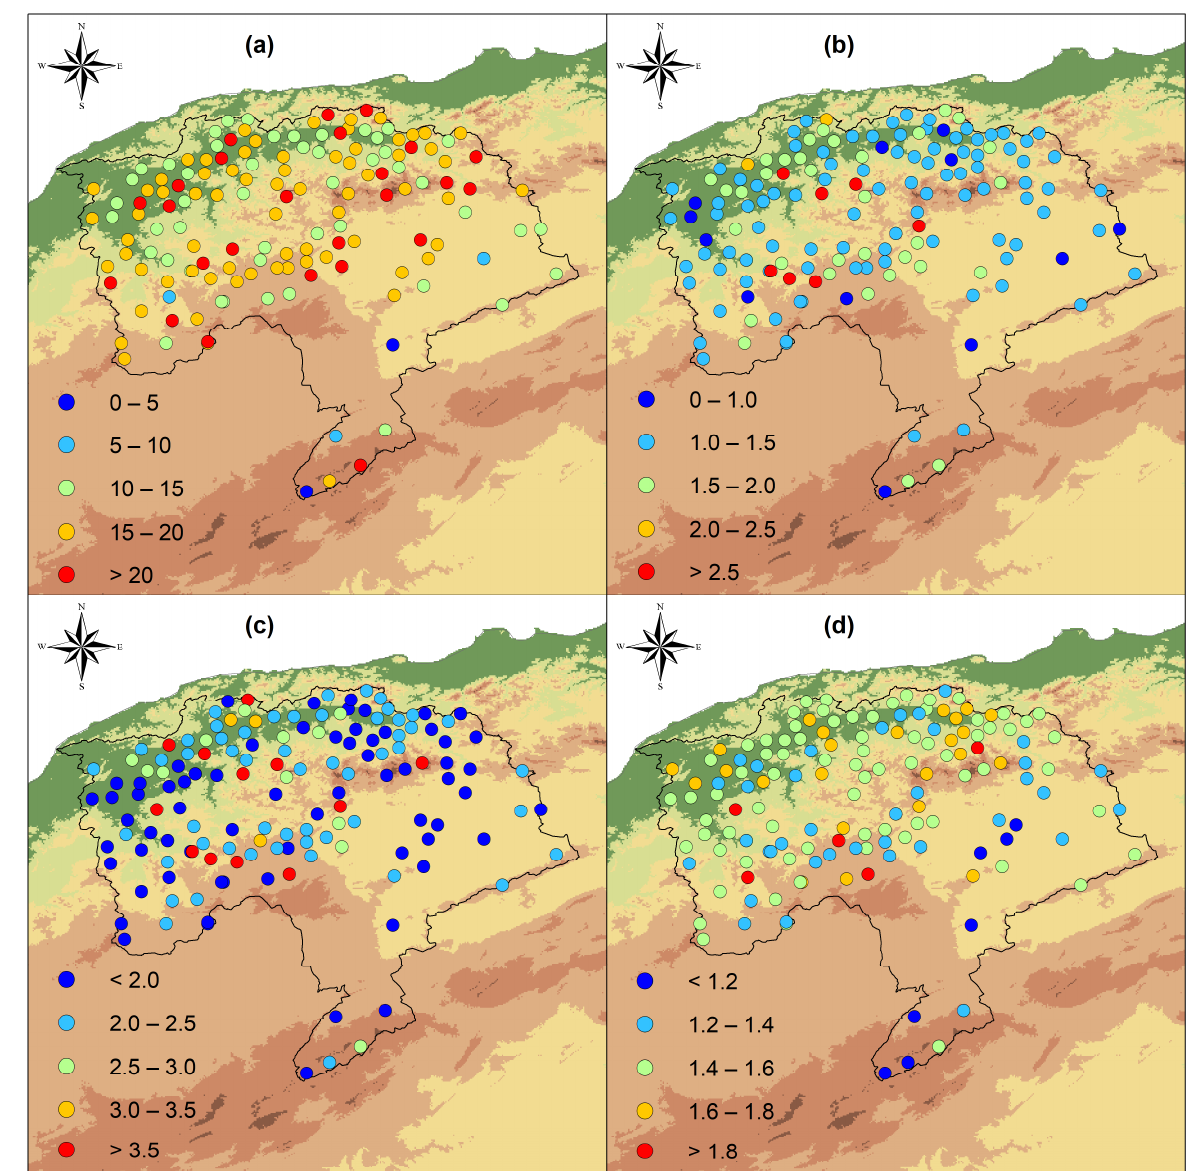
Figure 4. Spatial distribution of the ( a ) dry frequency in %, ( b ) average dry duration in years, ( c ) average dry severity and ( d ) average dry intensity in year −1 .